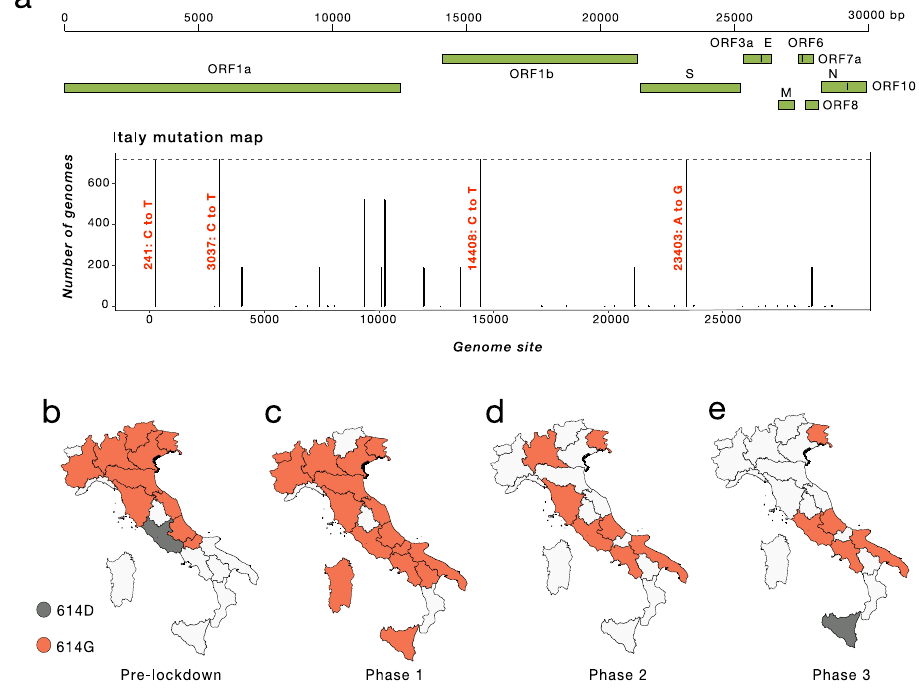
Fig. 4 Italian strains mutations pattern. a Variant maps of the most common mutations mapped against the SARS-CoV-2 genomes. Most common mutations de fi ned as mutations present in >90% of the genomes in that group (black lines). b – e Change in frequency of D614G mutation in the Spike Protein across Italian regions during epidemic phases. Italian regions are colored according to the dominant D614G mutation. White color represents missing genomic data from several Italian regions during epidemic